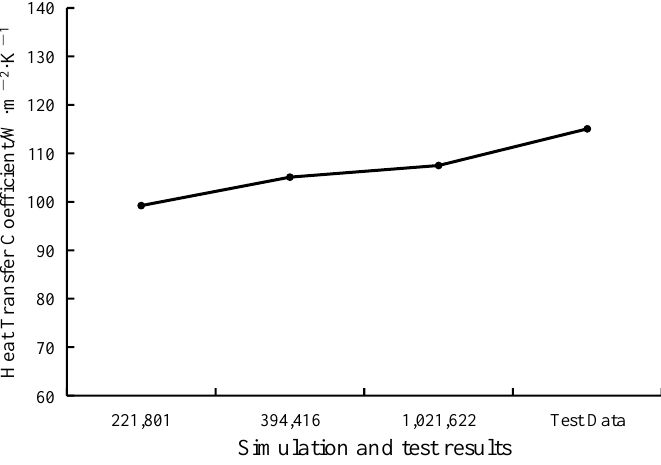
Figure 4. Discussion on grid dependence.